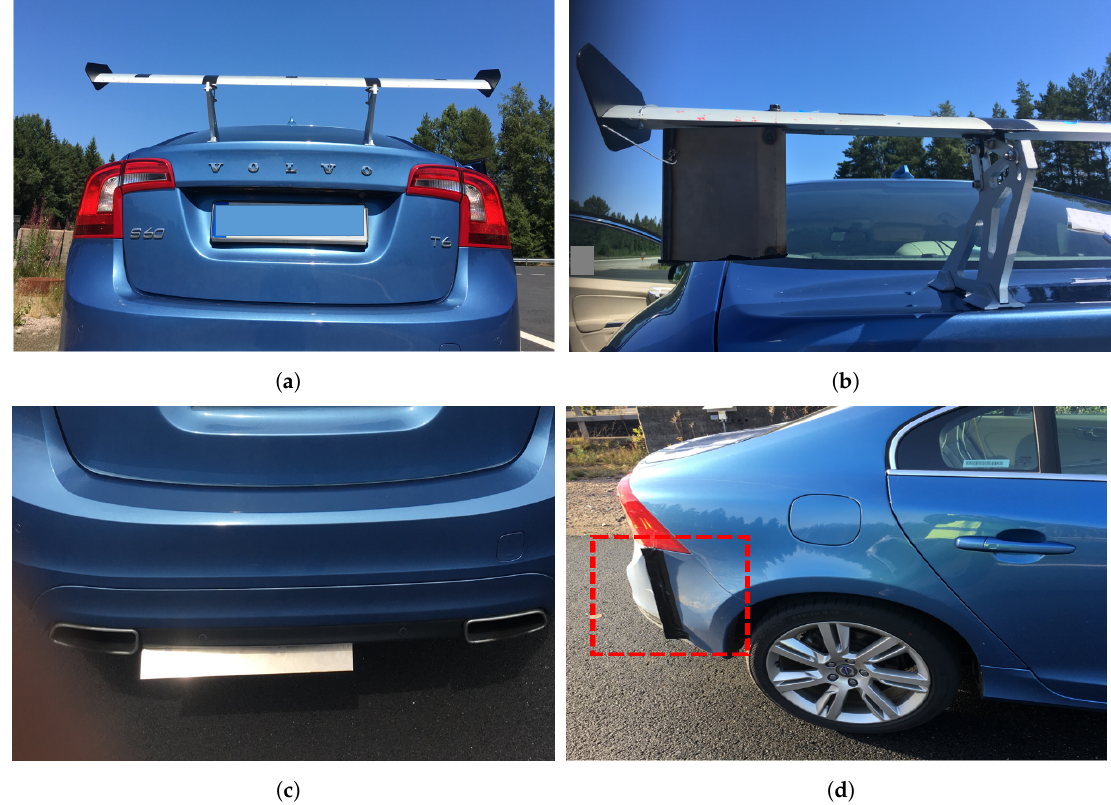
Figure 3. Aerodynamic Devices: ( a ) Inverted Wing [w]. ( b ) Inverted Wing with Fin [w-f]. ( c ) Anti- diffuser [a]. ( d ) Side-kicks